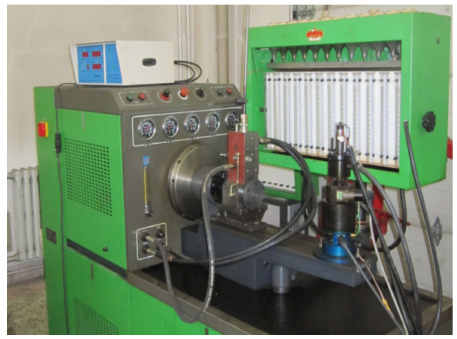
Figure 4. Fuel injection test